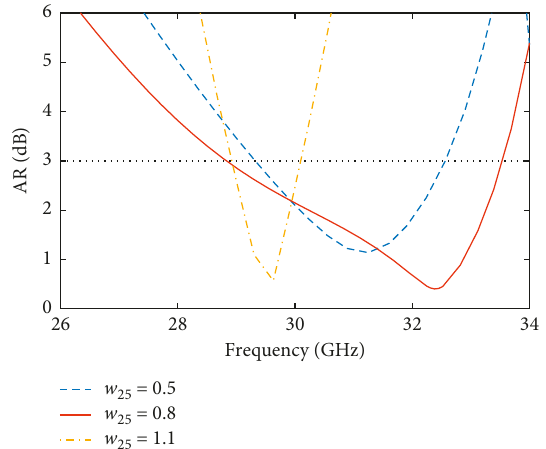
Figure 11: Effects of various w